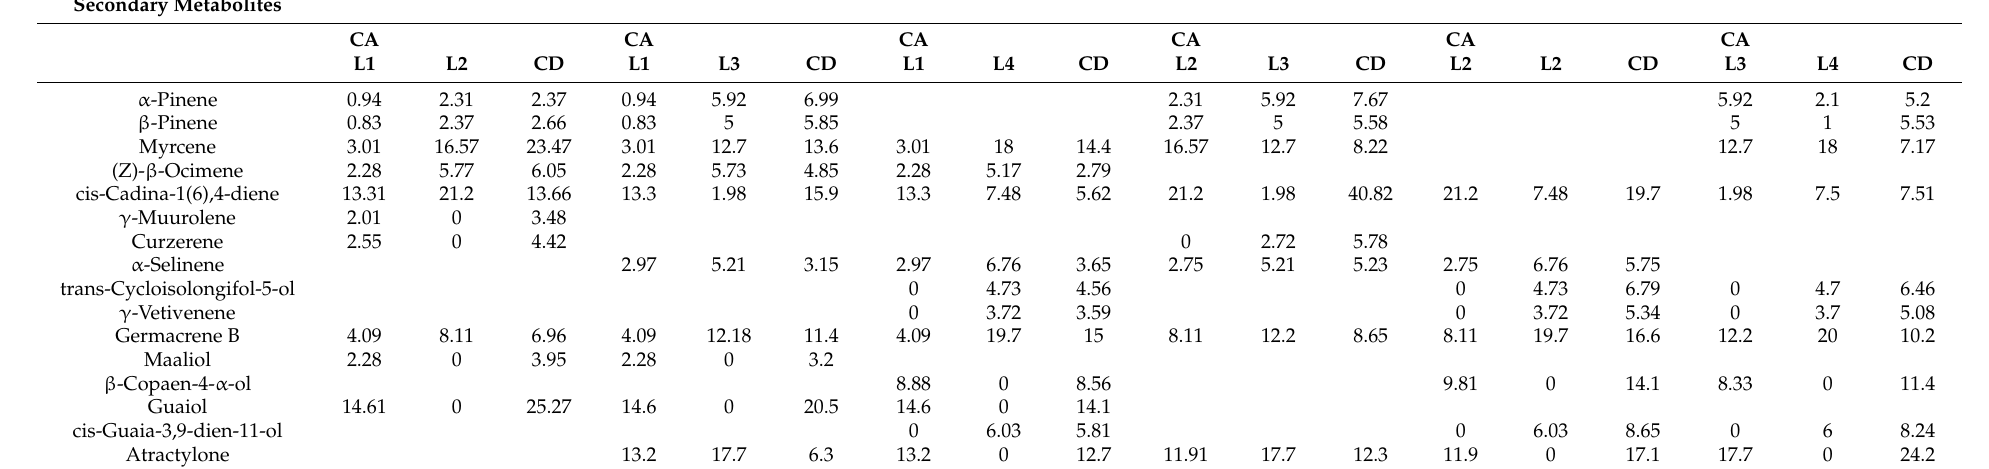
Table 7. Results of the SIMPER